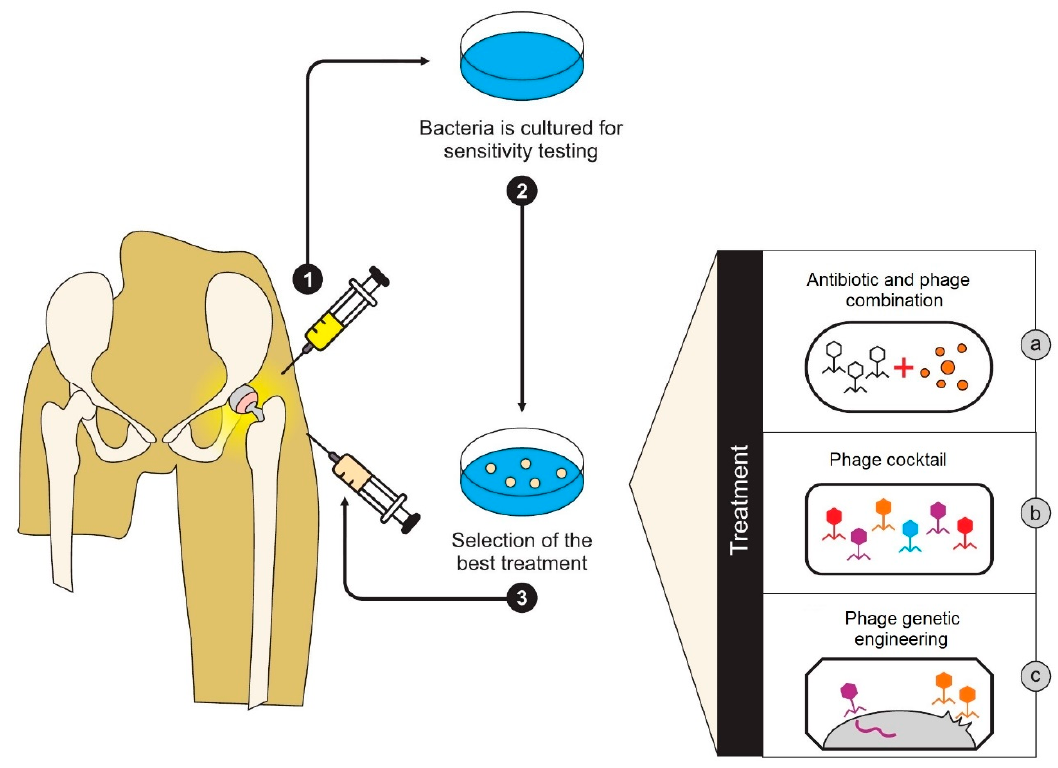
Figure 2. Personalized combinatorial phage therapy. Image adapted from Akanda et al.